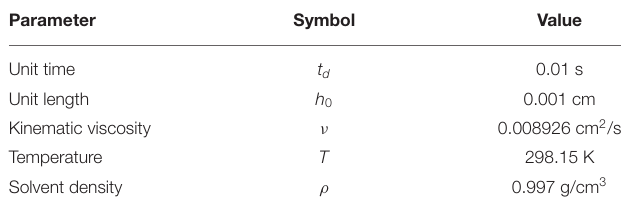
Ca 2 + and CO 2 − 3 TABLE 2 | Constant parameters used in